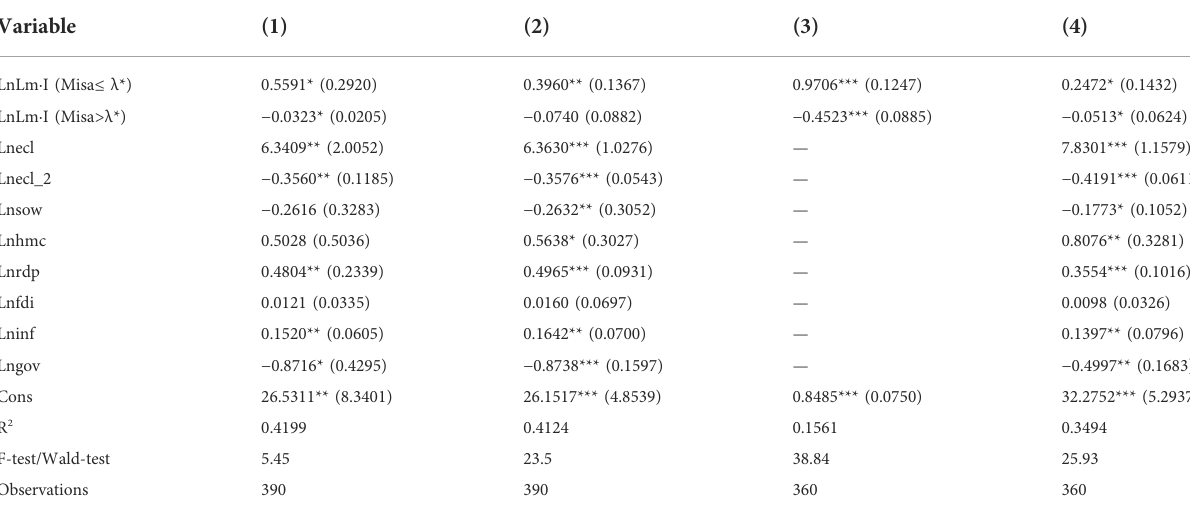
TABLE 7 Results of the robustness